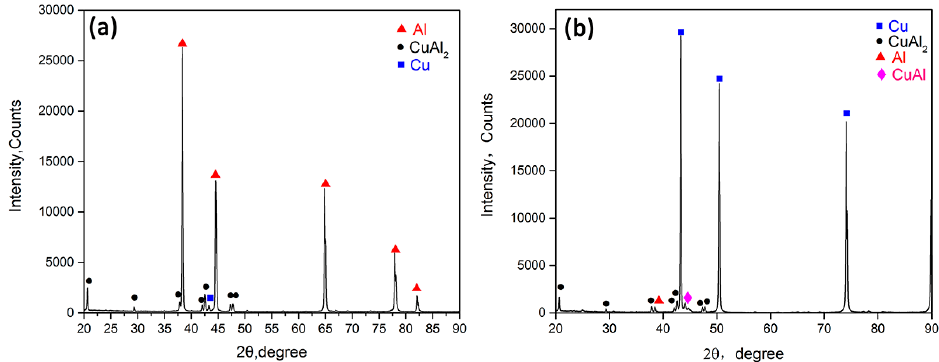
Figure 3. X-ray diffraction (XRD) patterns acquired from ( a ) the aluminum side and ( b ) the copper side of a fractured welding sample at an amplitude of 22.5 μ m and a weld time of 0.9 s.